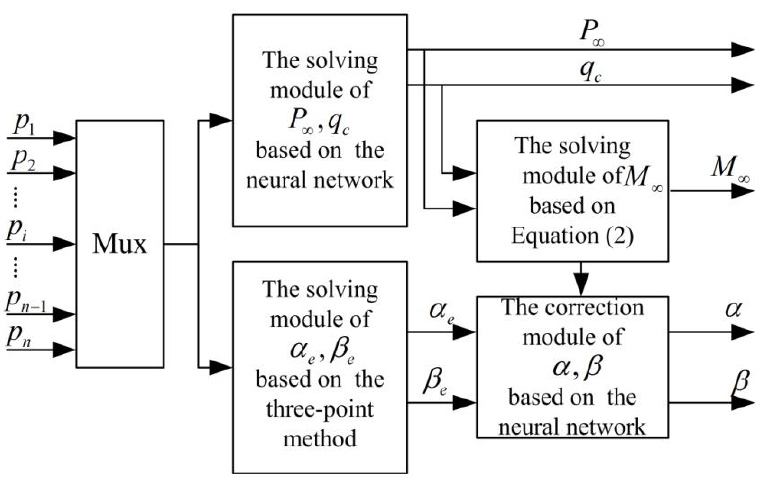
Figure 2. Structure diagram using neural networks for